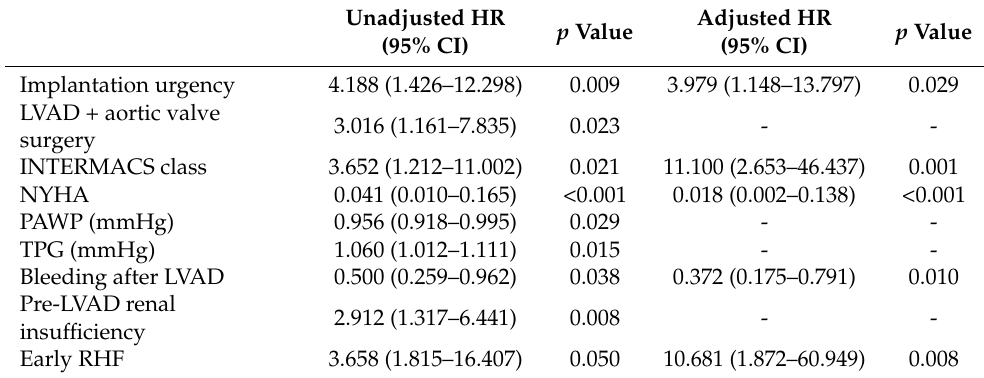
Figure 2. ( a ) Survival analysis against early RHF (7–14 days after LVAD implantation); ( b ) survival analysis against late RHF (>14 days after LVAD implantation). Table 2. Mortality